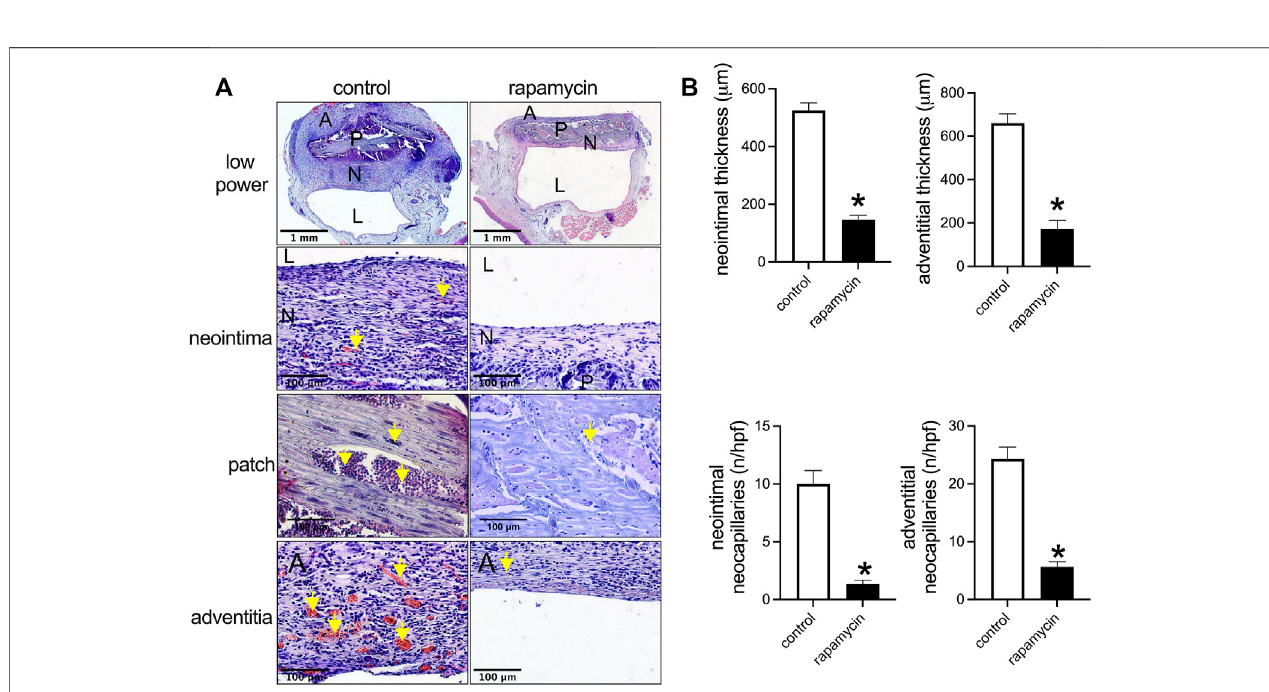
FIGURE4| Rapamycin-coatedwoodpatchesdecreasevenousneointimalhyperplasia. (A) Firstrow:lowpowermicrophotographsofhematoxylinandeosin(H&E)staining showingthecontrolandrapamycin-coatedwoodpatchesharvestedonday14;secondrow:highpowershowingtheneointima;thirdrow:highpowershowingthepatch;fourth row:highpowershowingtheadventitia;P,patch;N,neointima;L,lumen;yellowarrowshowsneocapillariesorin fi ltratedcells;scalebar,1 mmand100 μ m. (B) Bargraphsshow neointimal thickness (* p = 0.0001, t -test), adventitial thickness, neointimal neocapillaries (* p = 0.0001, t -test), and adventitial neocapillaries (* p = 0.0001, t -test); n = 3.